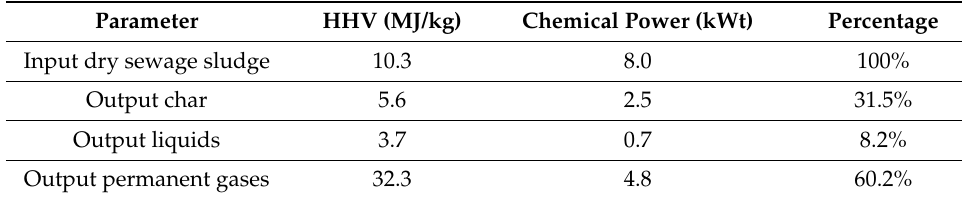
Table 8. Energy balance of slow pyrolysis test on SPYRO pilot